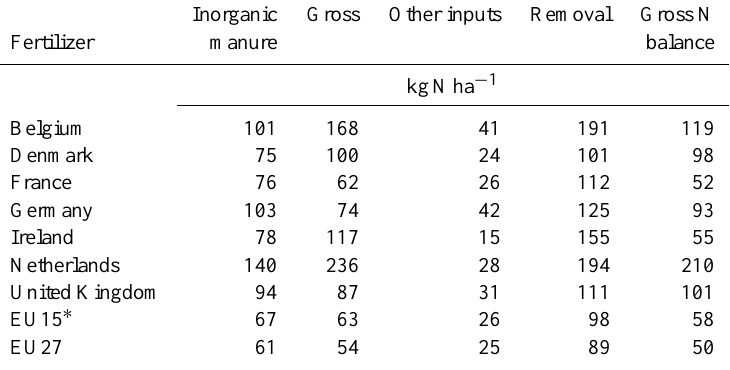
Table 5. Average annual inputs, crop removal and gross balance of nitrogen in 2005–2008 in northwestern member states of the EU (Eurostat, 2012).